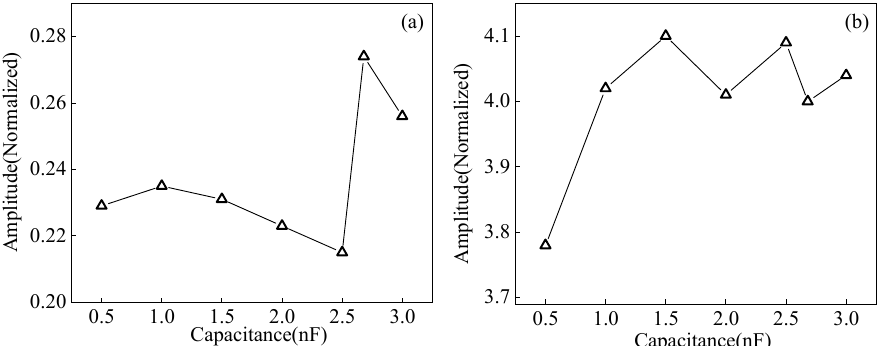
Figure 22. Influence of impedance matching capacitance on ( a ) the amplitude of the main lobe ( b ) the width of main lobe of the pulse-compressed signal in carbon steel specimen.